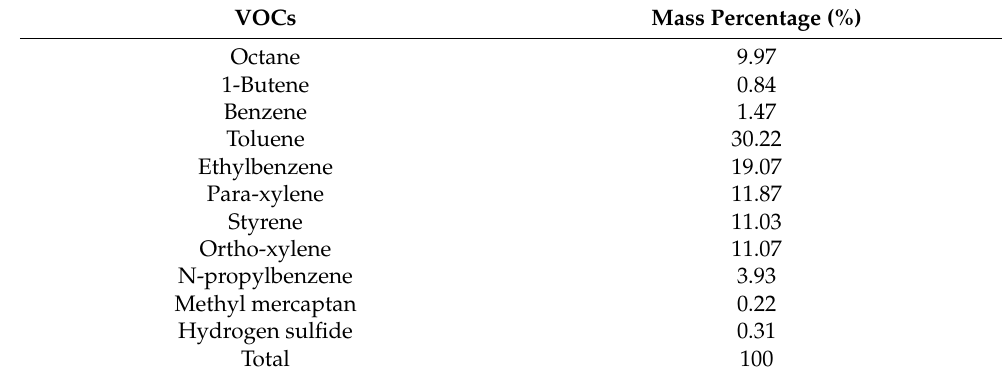
Table 3. Compositions for